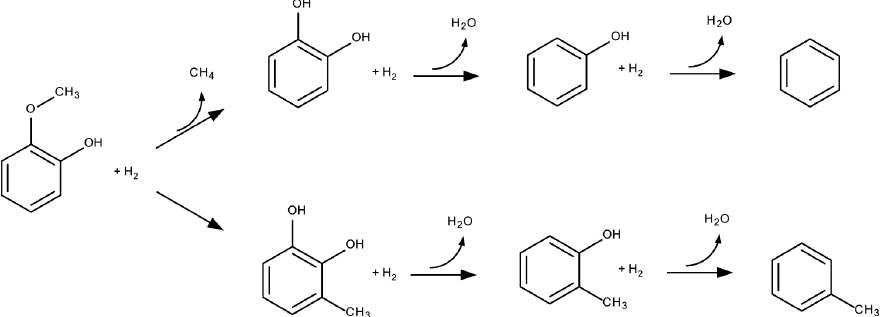
Figure 7. Proposed reaction network for guaiacol hydrodeoxygenation over Ni ‐ based catalysts at 350 °C [50].